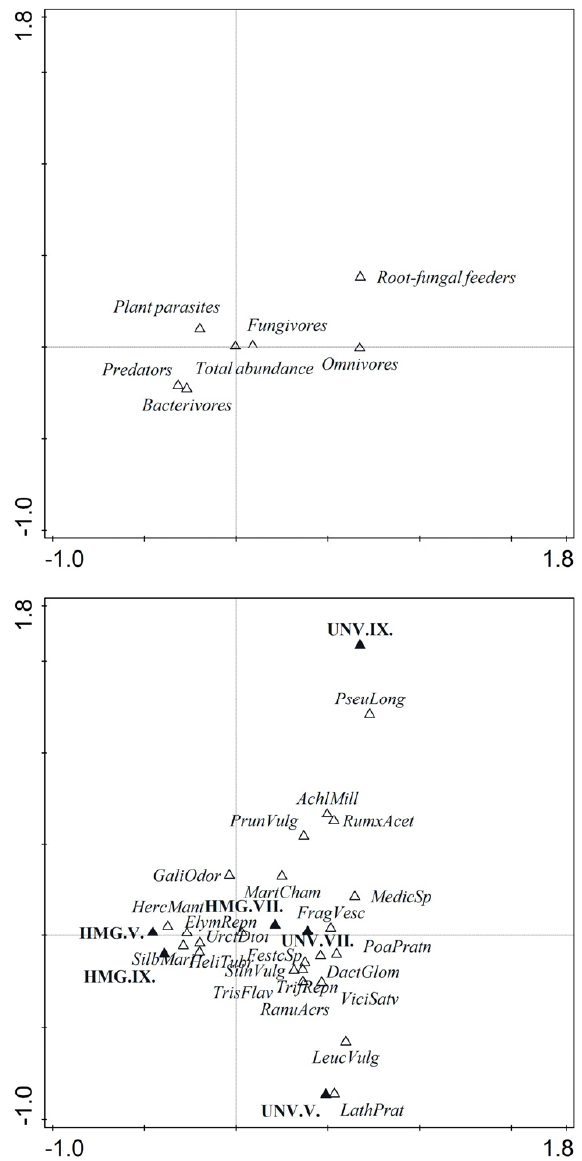
Figure 1. Biplot based on co-correspondence analysis illustrating the nematode trophic groups ( A ) and main plant species ( B ) common in Heracleum mantegazzianum invaded (HMG) and non- invaded (UNV) areas, 15.67% of the total variance of each dataset. Correlation coefficients be- tween nematode-derived and plant-derived site scores of the first three axes of symmetry cor- responded to the canonical analysis (axis 1: 0.6769, λ 1-0.121, p -0.0320, axis 2: 0.6842). Symbols represent soil samples collected in May (V), July (VII), and September (IX) of the two vegetation